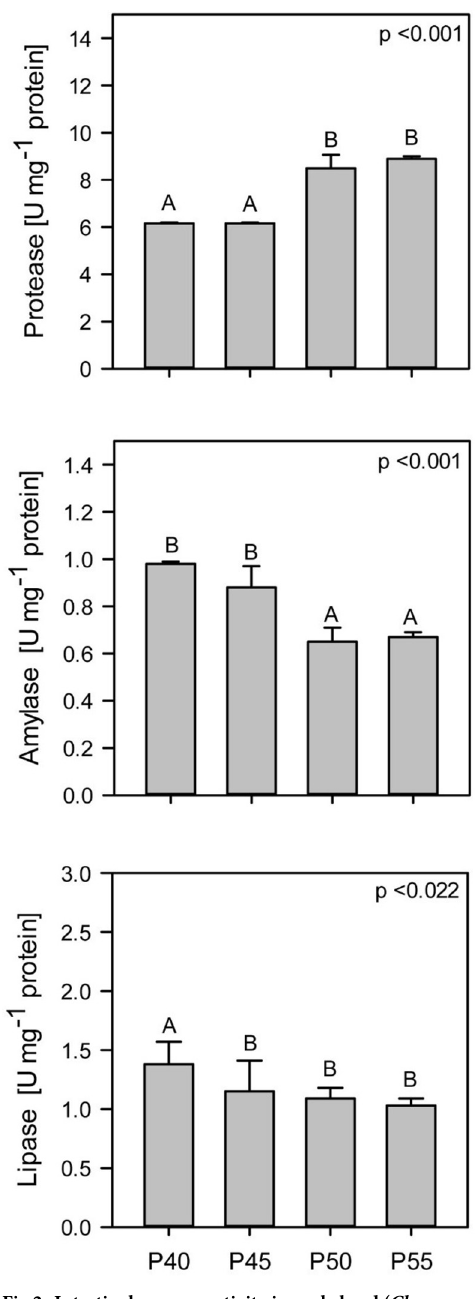
Fig 2. Intestinal enzyme activity in snakehead ( Channa marulius ) fish fed with increasing levels of protein ( ± SE). Diets: 40% (P40), 45% (P45), 50% (P50), 55% (P55) dietary protein level. Different superscripts indicate there is a significant difference (P <